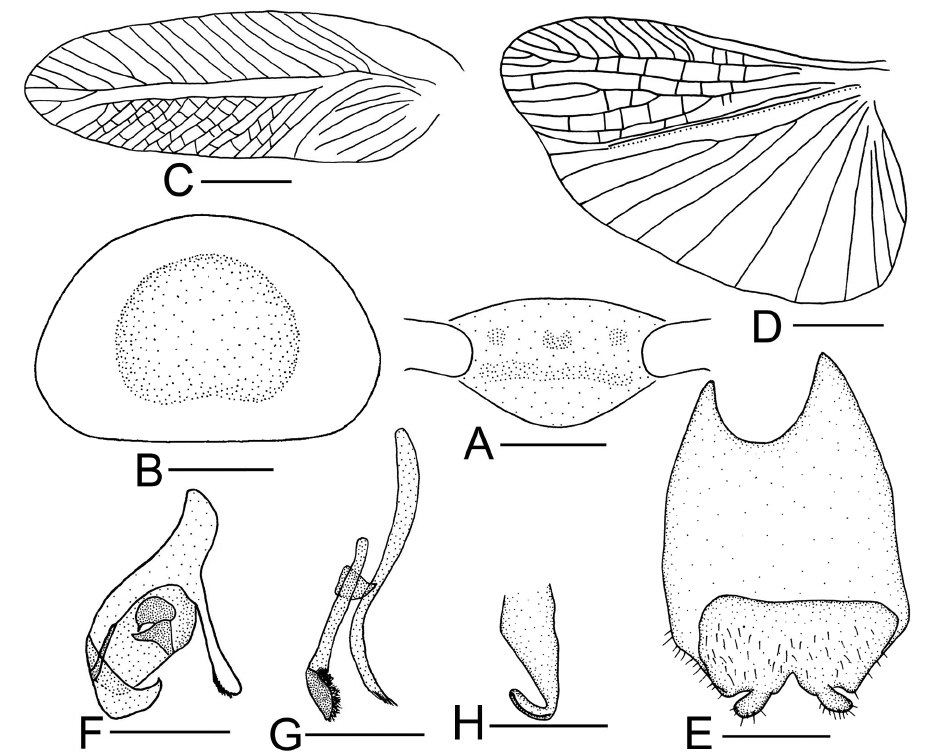
Figure 8. Sorineuchora viridis sp. n. holotype. A vertex B pronotum C tegmen D hind wing (the dotted line indicates wing fold) E subgenital plate, dorsal view F phallomere L1 G phallomere L2vm and R3 H phallomere R2. Scale bars: 0.5 mm ( A, E–H ), 1.0 mm ( B ), 2.0 mm ( C, D